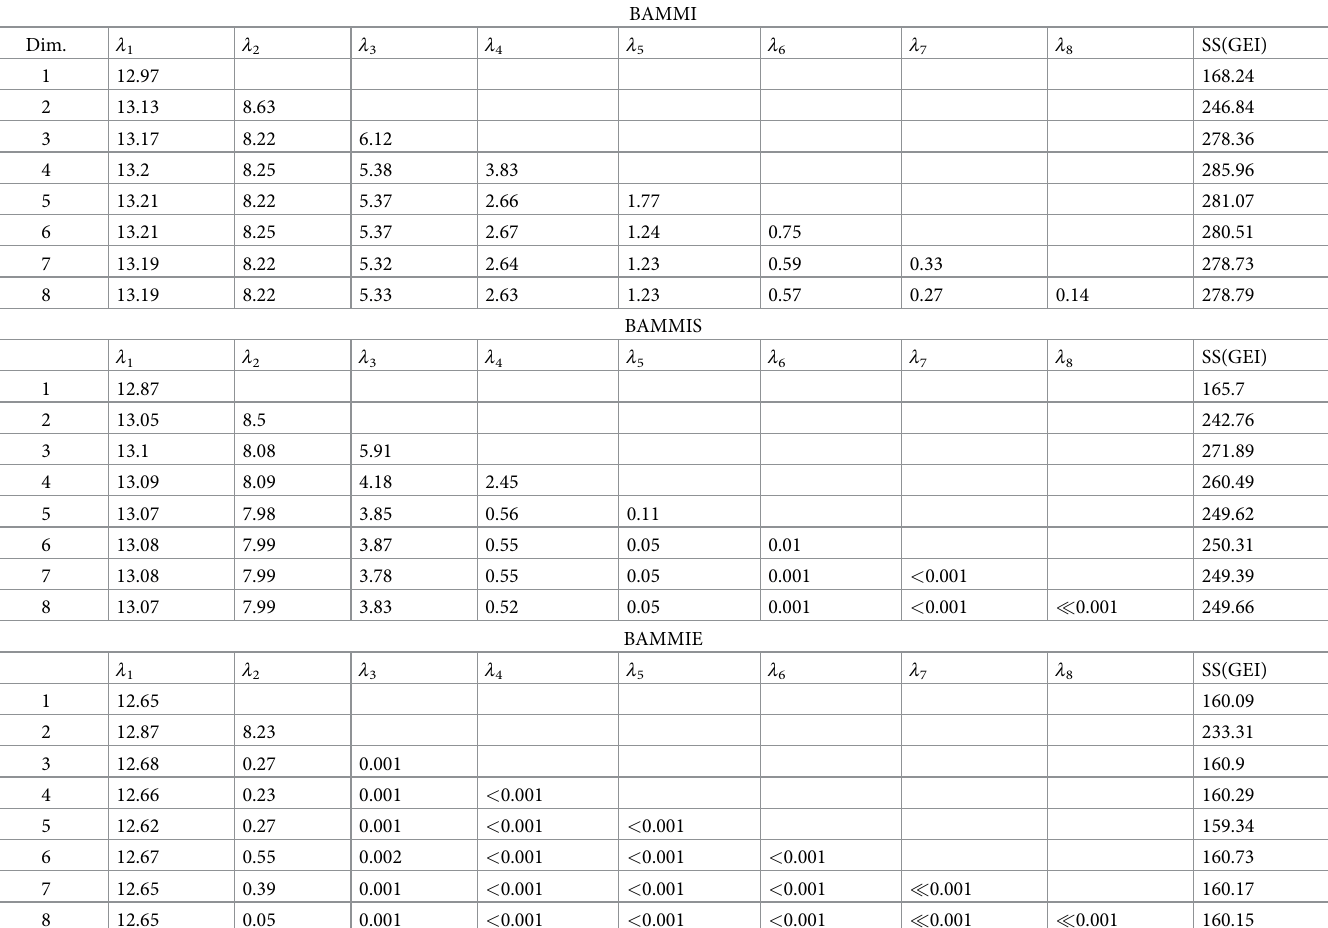
Table 1. Posterior means of singular values referent of each model (AMMI) and their respective accumulated sum of squares of the interaction in each dimension (Gibbs algorithm).